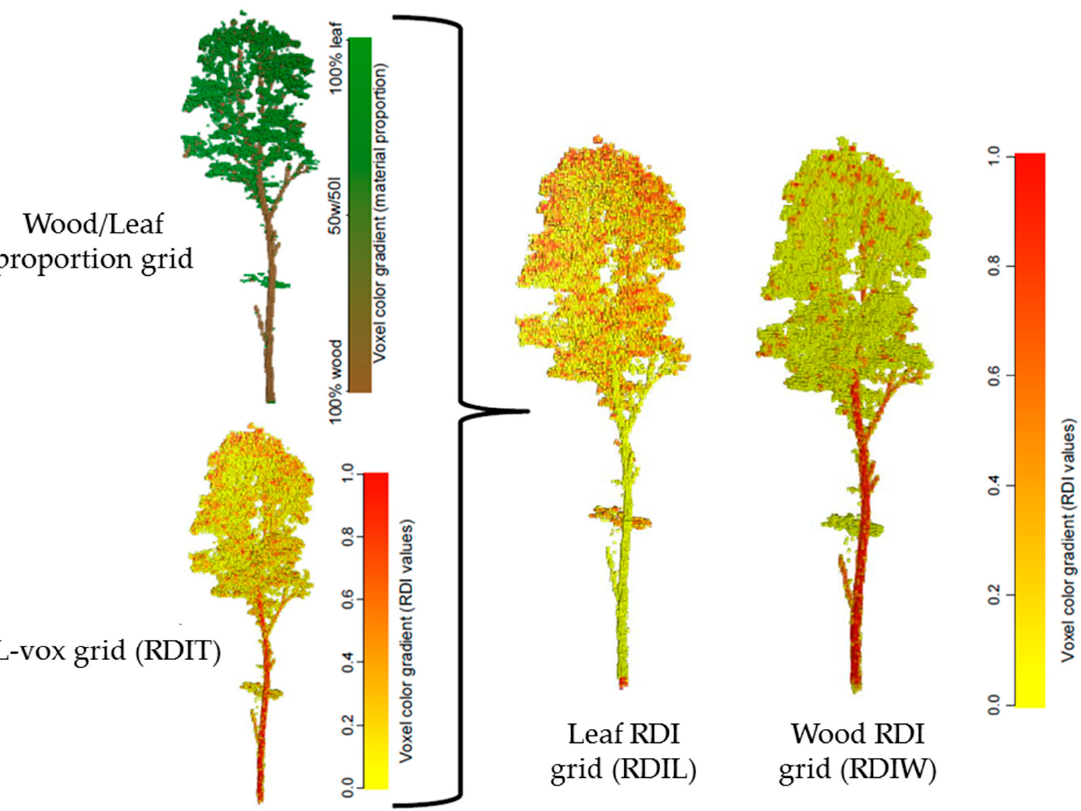
Figure 2. Illustration of the wood/leaves proportion grid and L-Vox grid representing the total relative density index (RDIT) profiles. Combining the voxel representation of the wood/leaves proportion grid and the RDIT allows obtaining wood density relative index (RDIW) and leaf density relative index (RDIL) profiles.